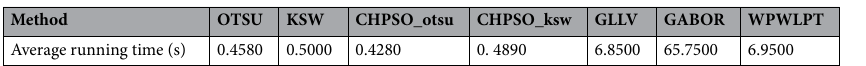
Table 9. The average running times (s) of different thresholding methods for all the 22 test